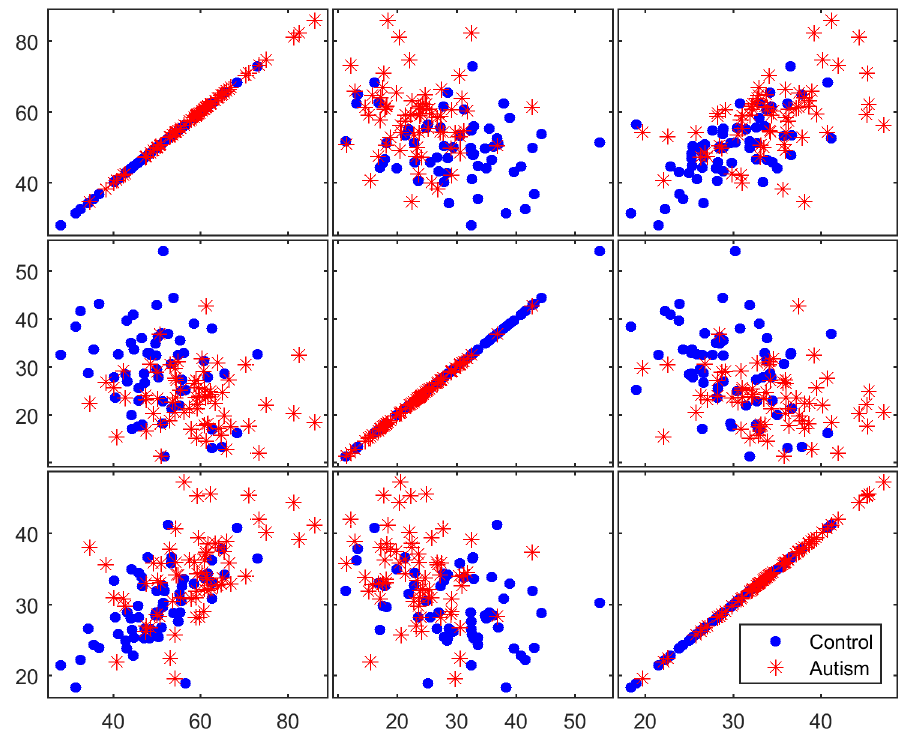
Fig 10. Matrix plots for three representative selectedgenes from the 200 genes filtered by the COR method.